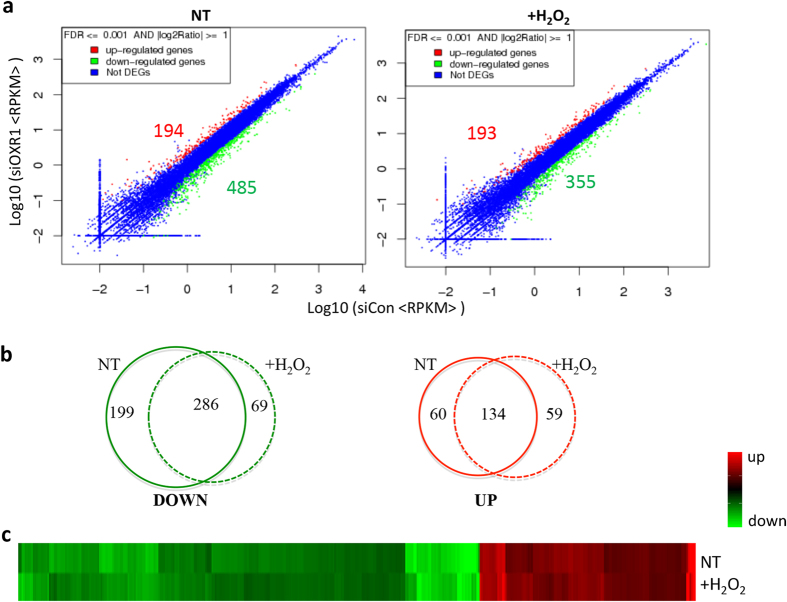
The differential expression profile in hOXR1 depleted HeLa cells.The HeLa cells were transfected with control siRNA (siCon) or hOXR1 siRNA (siOXR1) and, split into six-well plate after one day. One day later cells were treated without (NT) or with 0.5 mM H2O2 for 1 h. Cells were harvested immediately without recovery (R0h). The total RNA was isolated and analyzed by RNA-seq. (a) Scattered plot of hOXR1-depleted cells show differentially expressed genes without (NT) or with peroxide treatment (+H2O2). (b) Venn diagram analysis of common/unique down- and up-regulated genes in hOXR1 depleted cells without (NT) or with peroxide treatment (+H2O2). (c) Heatmap showing the overview of total DEGs caused by hOXR1 depletion. Red: up regulation; green: down regulation; black: no change.